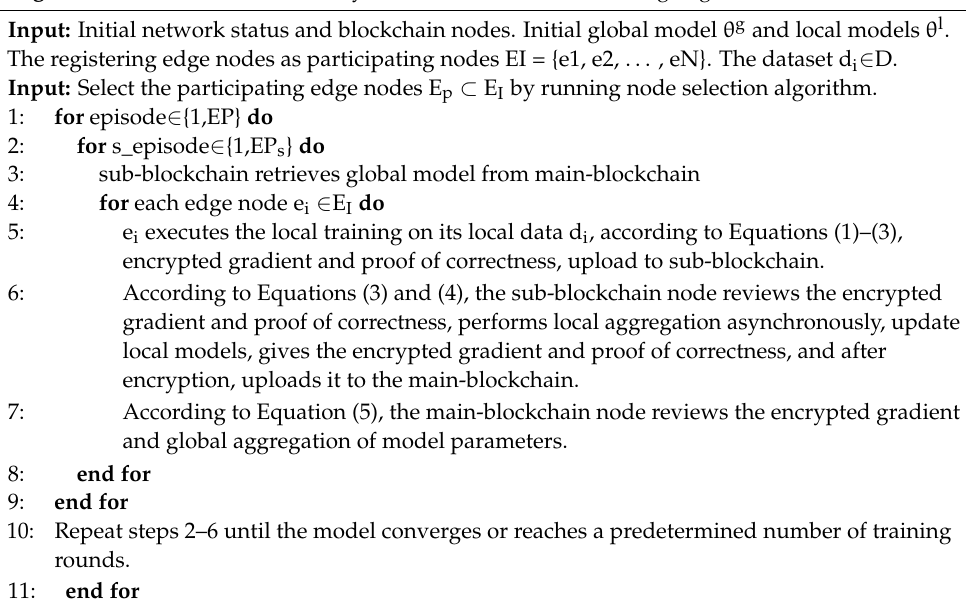
Algorithm 1: Blockchain-Based Asynchronous Federated Learning